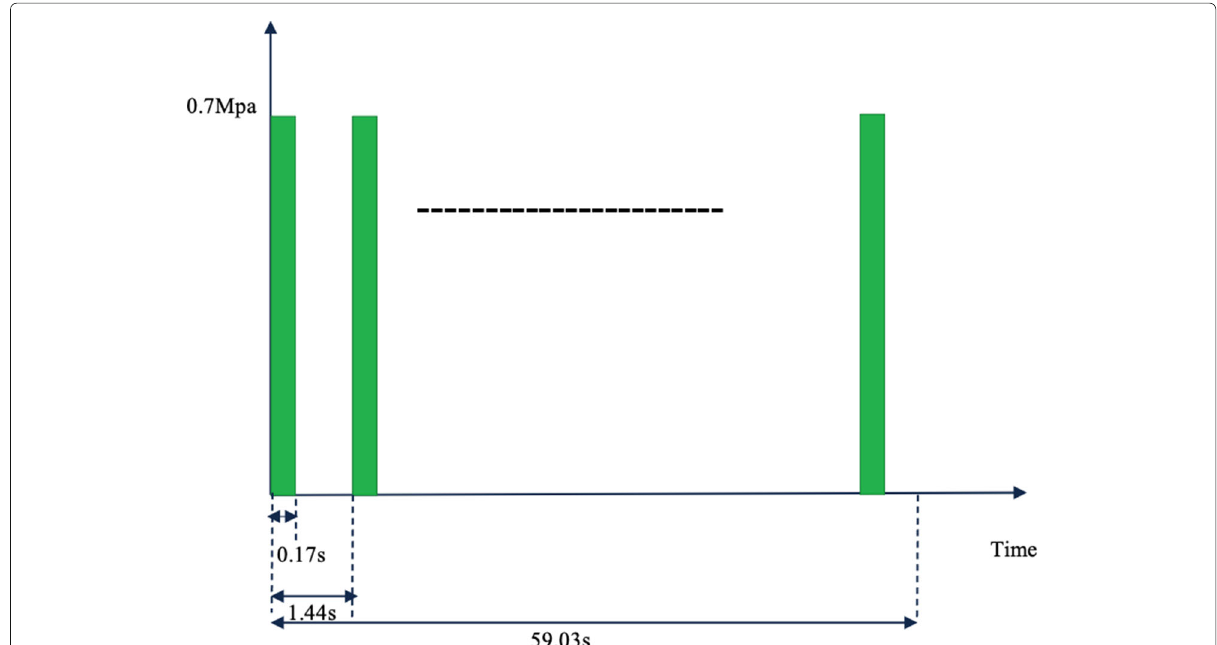
Fig. 4 Cyclic loading